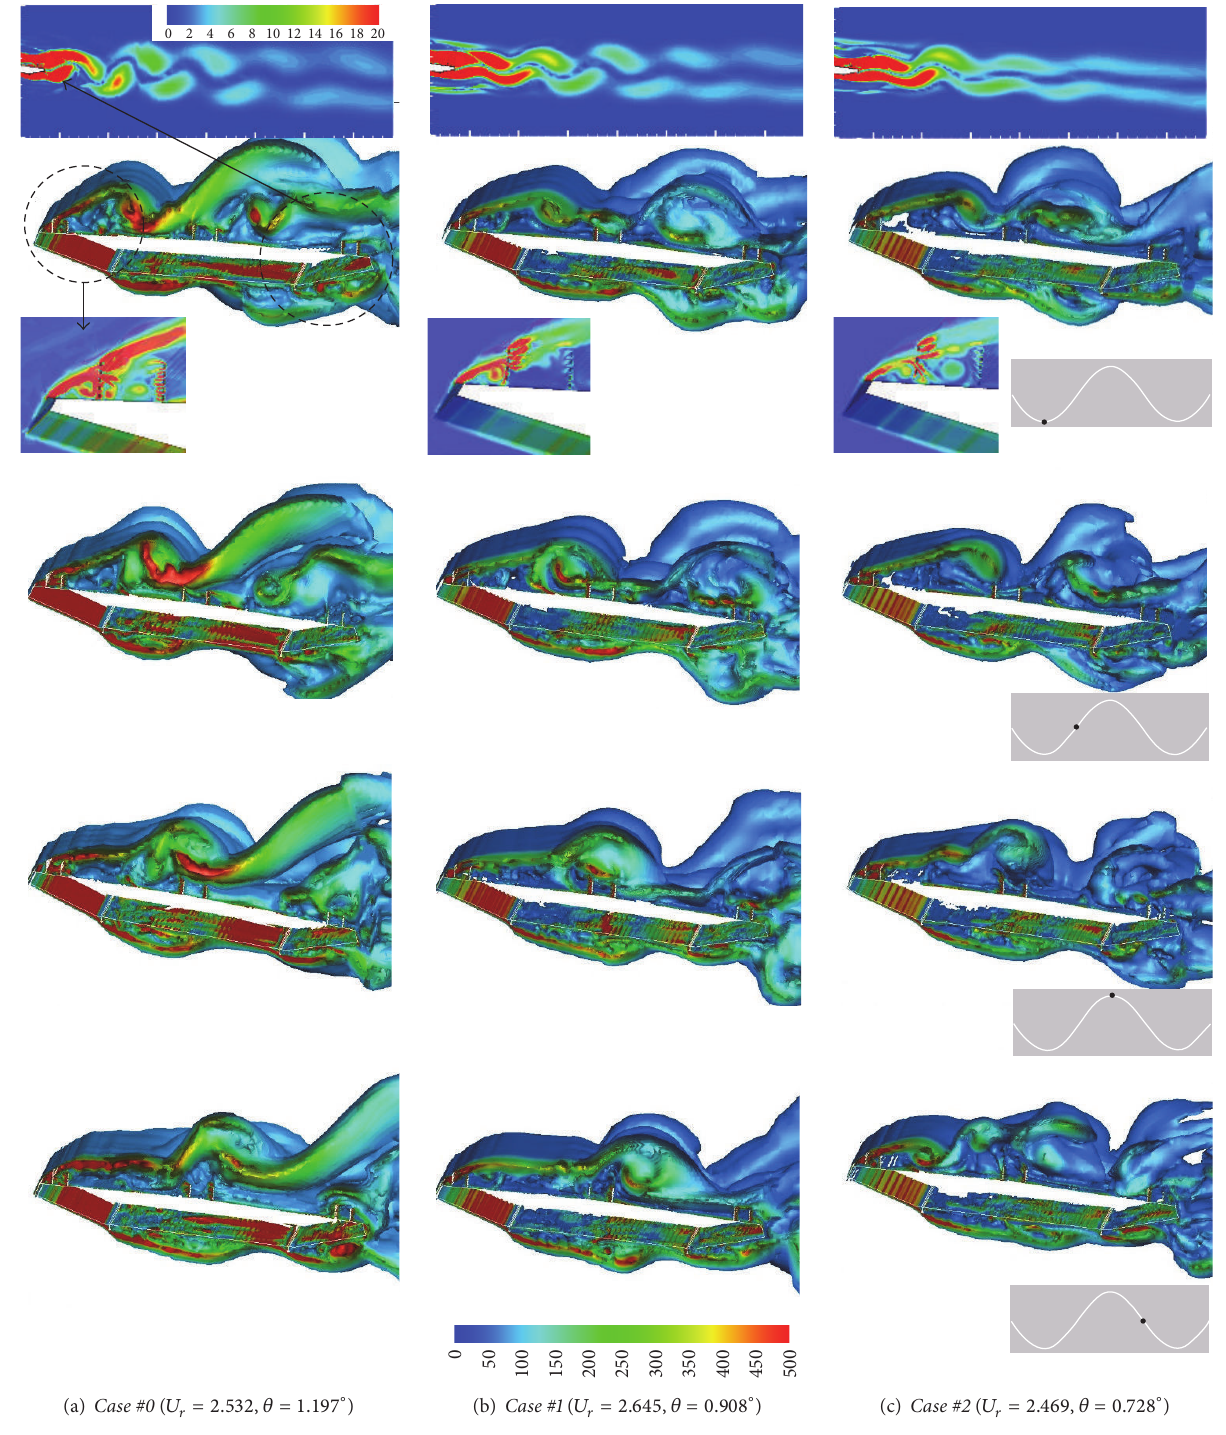
Figure 18: Instantaneous vorticity contours in a periodic torsional VIV ( 𝛼 = +5 ∘ ).